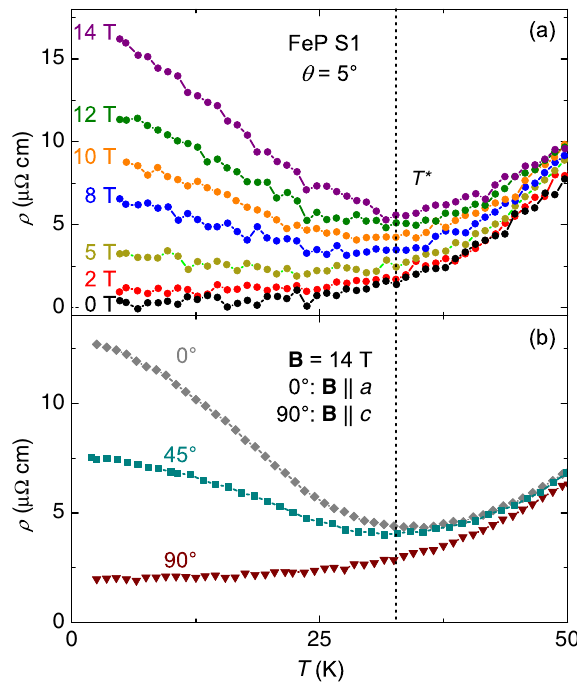
Fig. 4 Temperature dependence of sample S1 for different magnetic fi eld strengths and orientations. a Temperature depen- dence at the maximal magnetoresistive angle for fi eld in the a – c plane ( θ = 5°) from Fig. 3a, in zero and various applied fi elds. b Temperature-dependent MR of the same sample at three more angles and 14 T; for all three, at least the beginning of a plateau is apparent at low temperature, in contrast to the θ = 5°, 14-T data in ( a